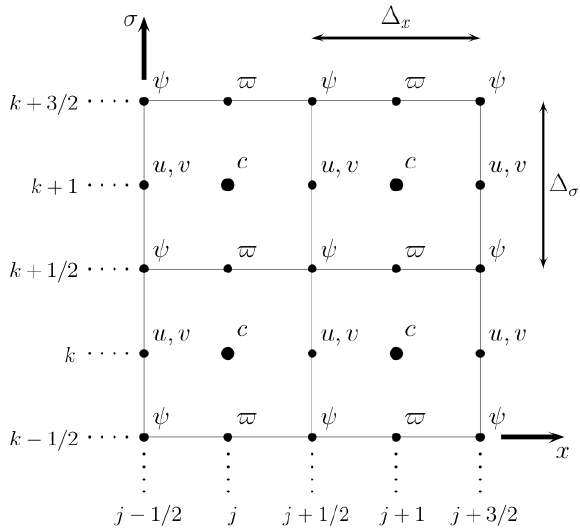
Figure 2. Illustration of the numerical grid used to compute solu- tions to the model